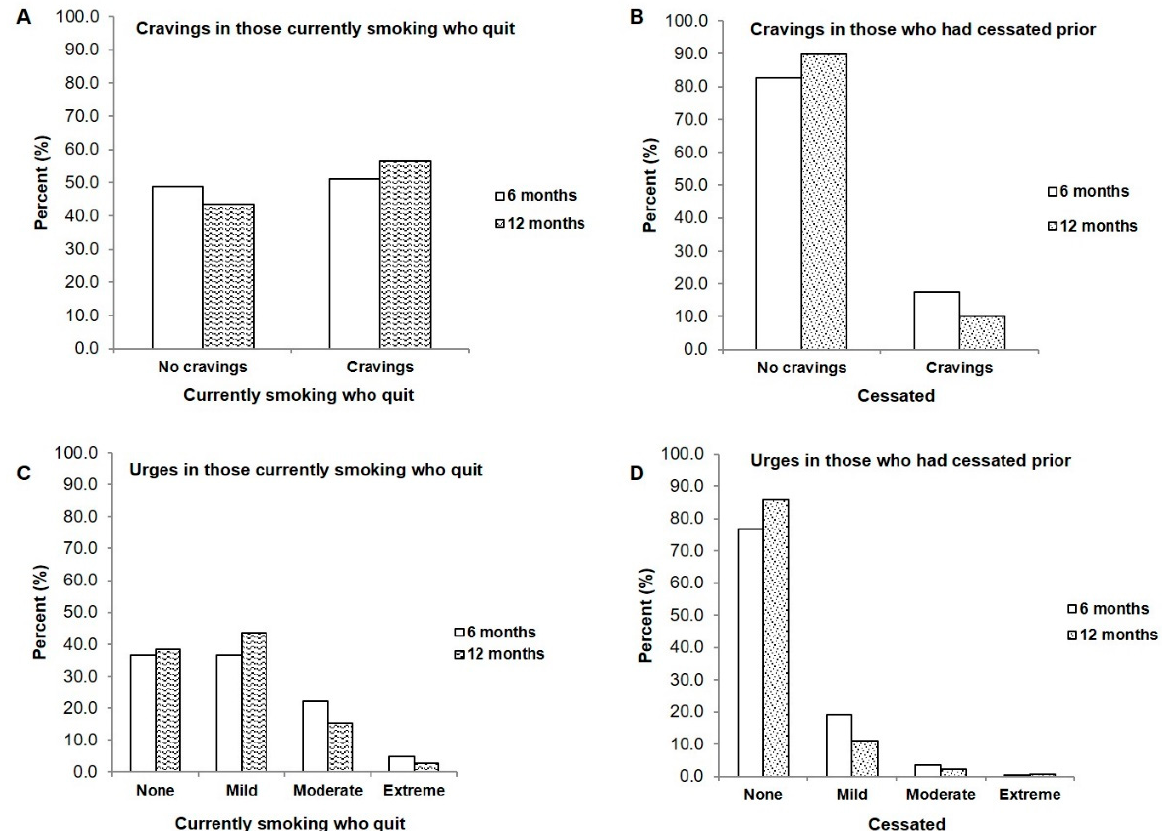
Figure 2. Comparison of cravings and urges between patients who were smoking and who quit after enrollment in a clinical tobacco intervention and those who were already cessated at the start of the study ( A ) Cravings in those smoking who quit, at 6 months ( n = 41) and 12 months ( n = 39) ( B ) Cravings in those who were cessated at 6 months ( n = 281) and 12 months ( n = 276) ( C ) Urges to smoke in patients who were smoking and quit at 6- and 12-months compared to ( D ) Urges to smoke in those who had already cessated.